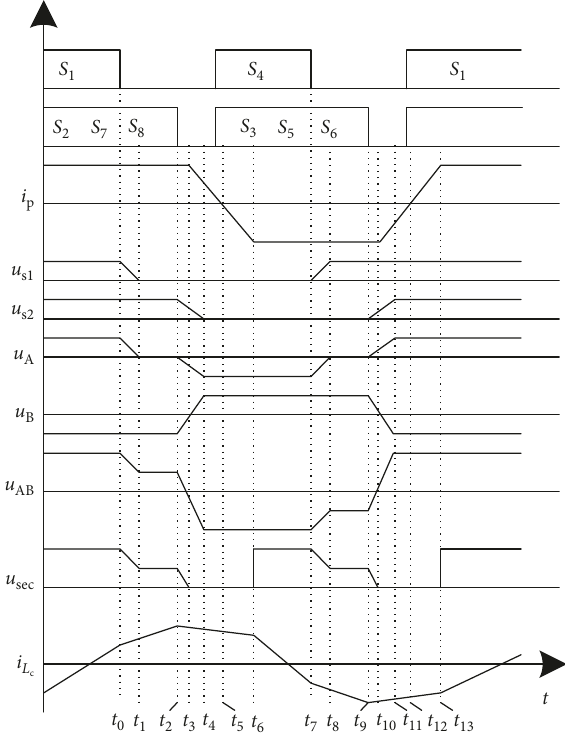
Figure 7: Operation waveforms of three-level controlled-source circuit.